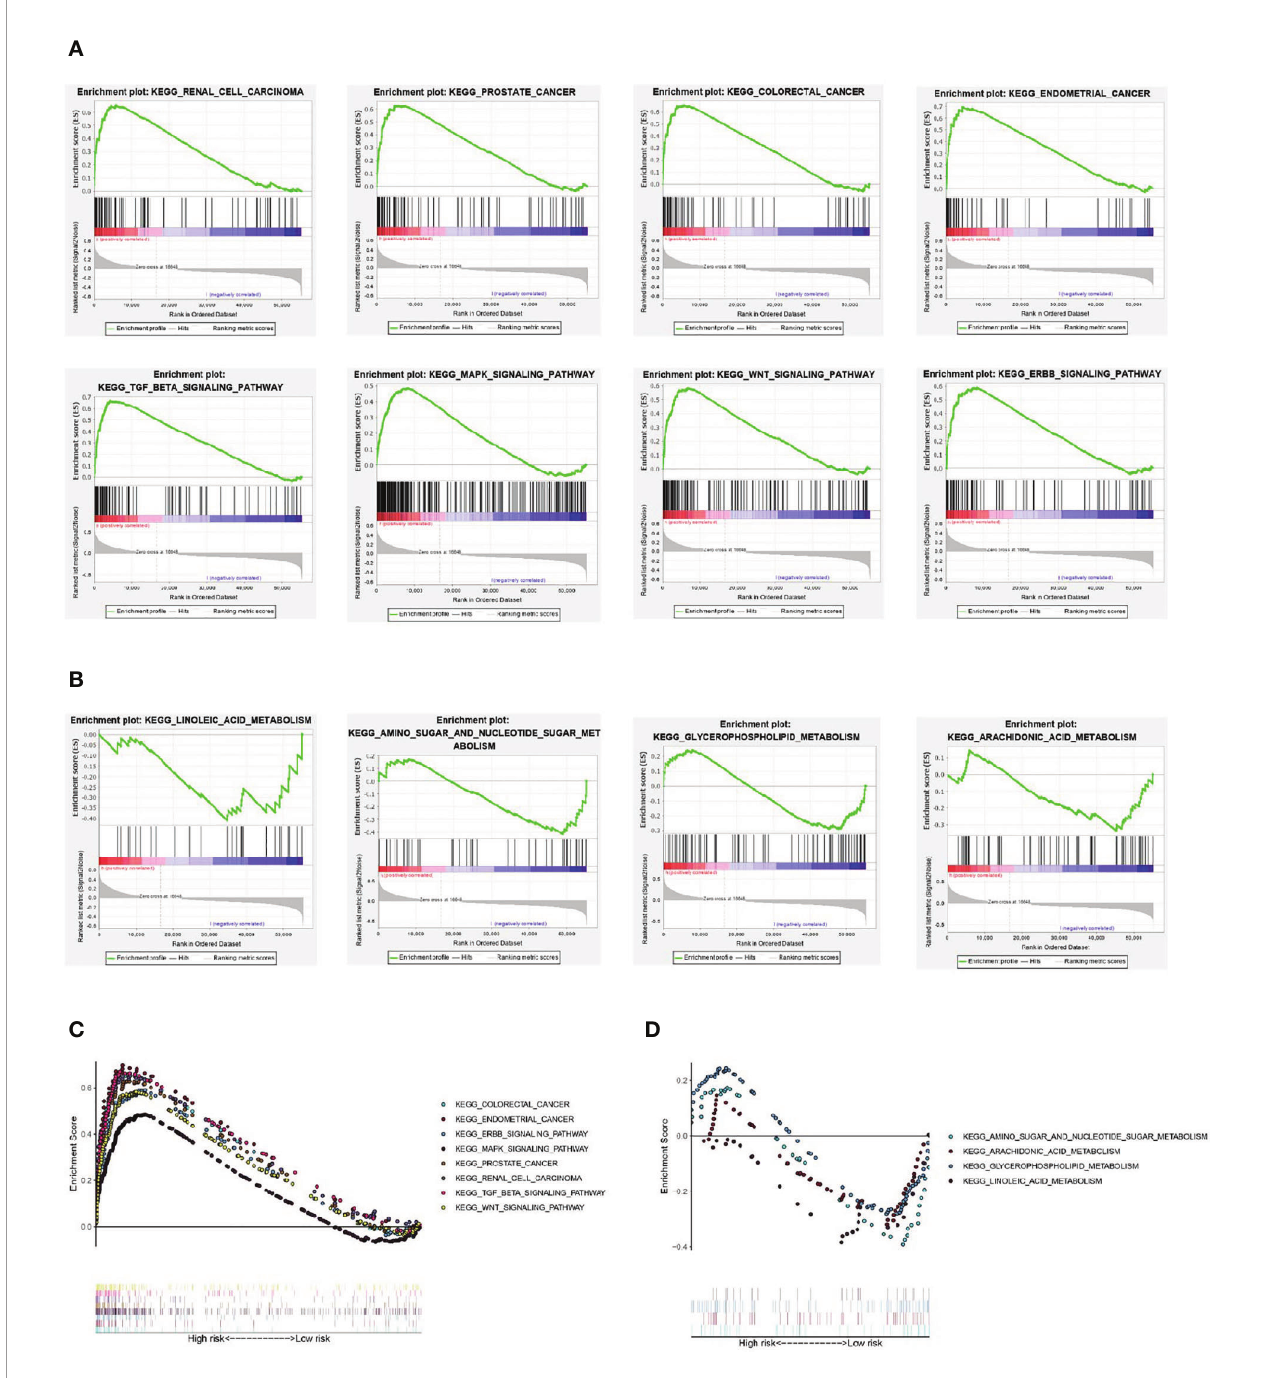
FIGURE 7 | Gene set enrichment analysis. (A, C) Renal cell carcinoma, colorectal cancer, endometrial cancer, prostate cancer, ERBB signaling pathway, MAPK signaling pathway, WNT signaling pathway, and TGF- b signaling pathway were signi fi cantly enriched in the high-risk group. (B, D) amino sugar and nucleotide sugar metabolism, arachidonic acid metabolism, glycerophospholipid metabolism, linoleic acid metabolism were signi fi cantly enriched in the low-risk